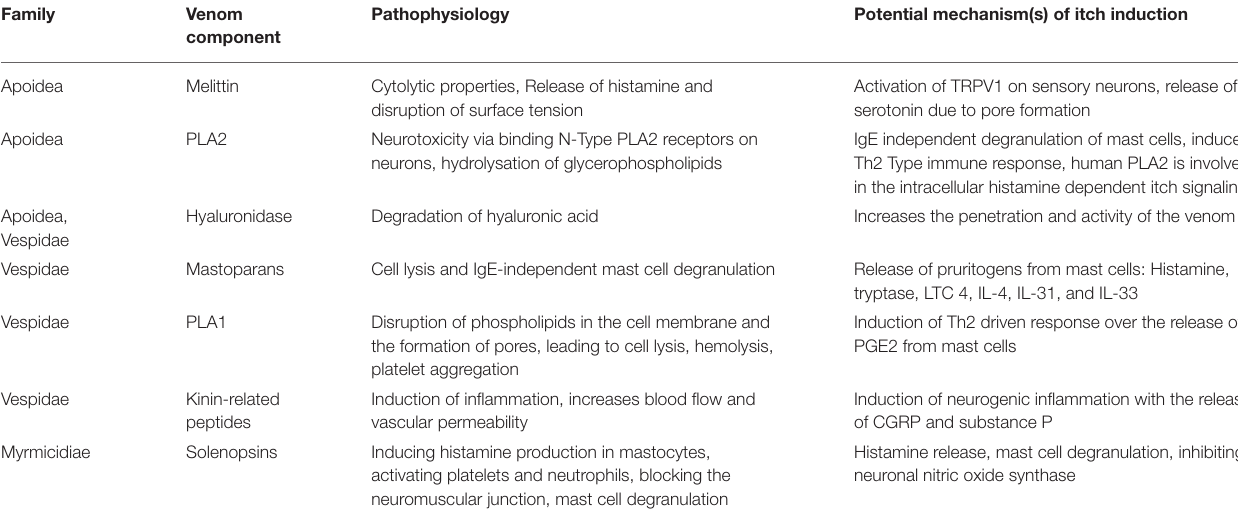
TABLE 1 | Components of Hymenoptera venoms with their potential mechanism(s) of itch induction. Family